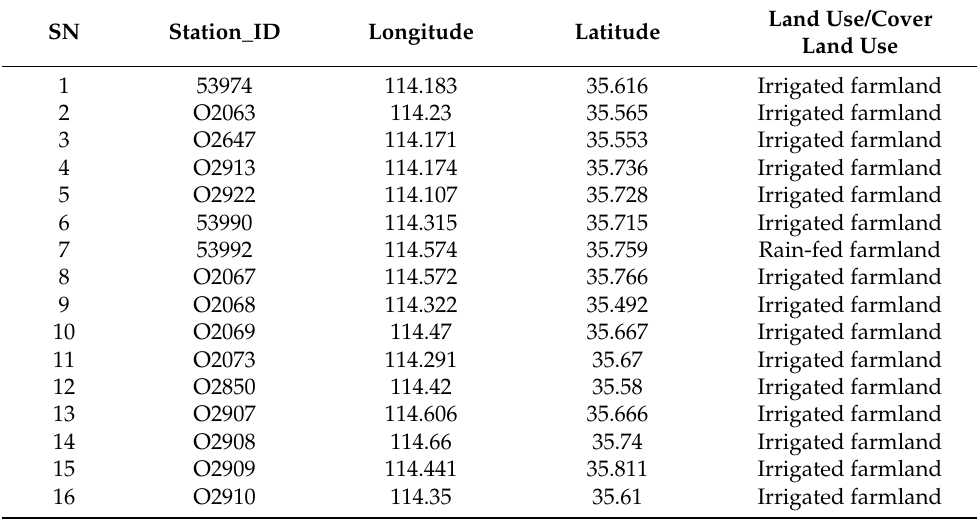
Table 1. Location and land use for the 16 in situ soil moisture